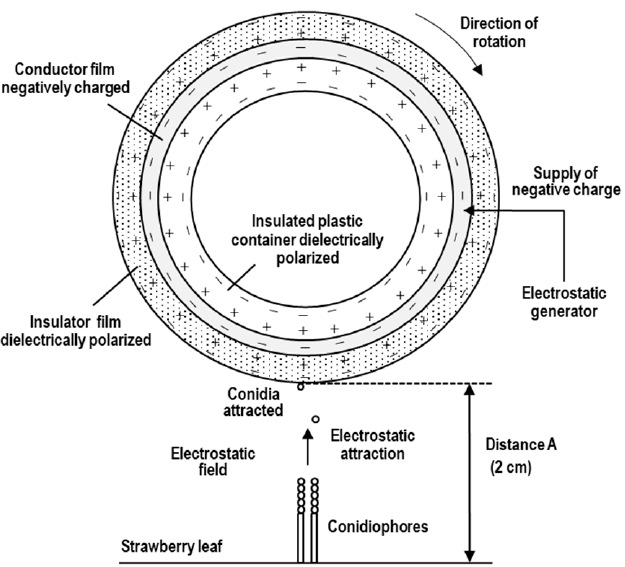
Figure 5. Diagram of the rotational electrostatic apparatus for collecting progeny conidia released from conidiophores in a single KSP-7N colony formed on a leaf of a strawberry seedling (cross- sectional view). A negative charge, which was produced from the electrostatic voltage generator, transferred to the conductor (copper) film. A positive “image charge” on the surface of the insulator film was induced by the negative charge on the conductor film. A negative surface charge on the opposite side of the insulator film was produced by dielectric polarisation. An electrostatic field was formed around the dielectrically polarised insulator film. Progeny conidia released from conidiophores were electrostatically attracted to the insulator film.